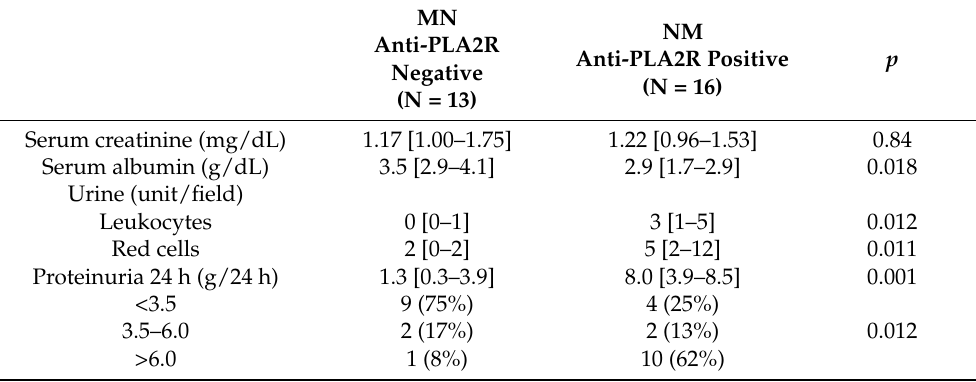
Table 4. Comparison between negative and positive anti-PLA2R serum MN patients at the time of inclusion in the